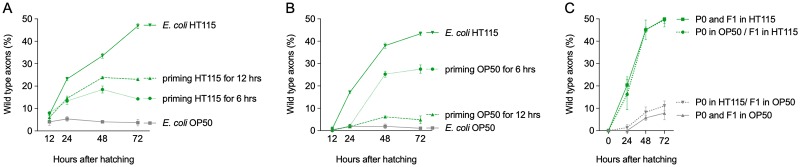
Diet of E. coli HT115 at early stages of life is necessary and sufficient to confer neuroprotection.(A and B) Percentage of wild-type axons of animals fed for 6 and 12 hours with (A) E. coli HT115 or (B) E. coli OP50 and then changed to OP50 or HT115 diet, respectively. (C) Percentage of wild-type axons of animals feeding on either E. coli OP50 or HT115 whose parents were fed on either diet. The underlying numerical data and statistical analysis for each figure panel can be found in S1 and S2 Datasets, respectively. F, filial generation; P, parental generation.